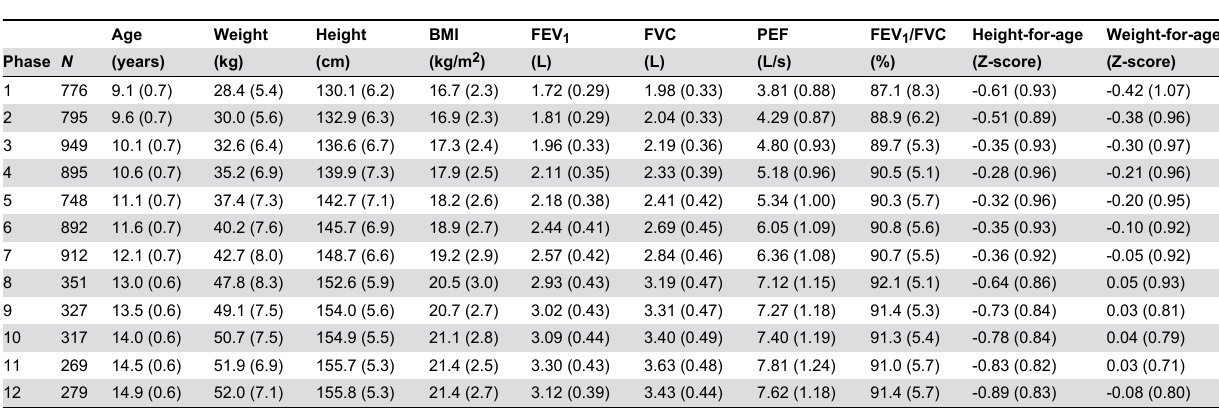
Table 2. Main characteristics of girls studied (means and